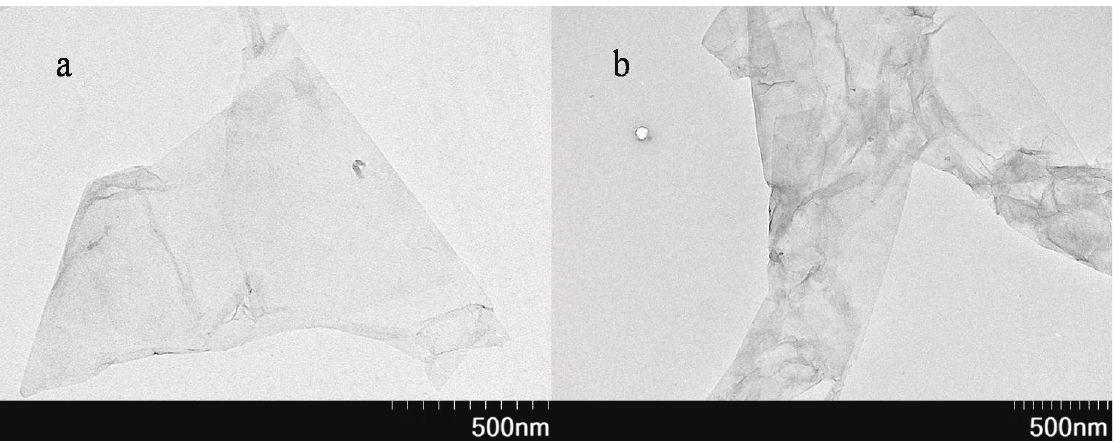
Figure 3: TEM images of GO suspensions (a), and GO+PAHs+NaCl